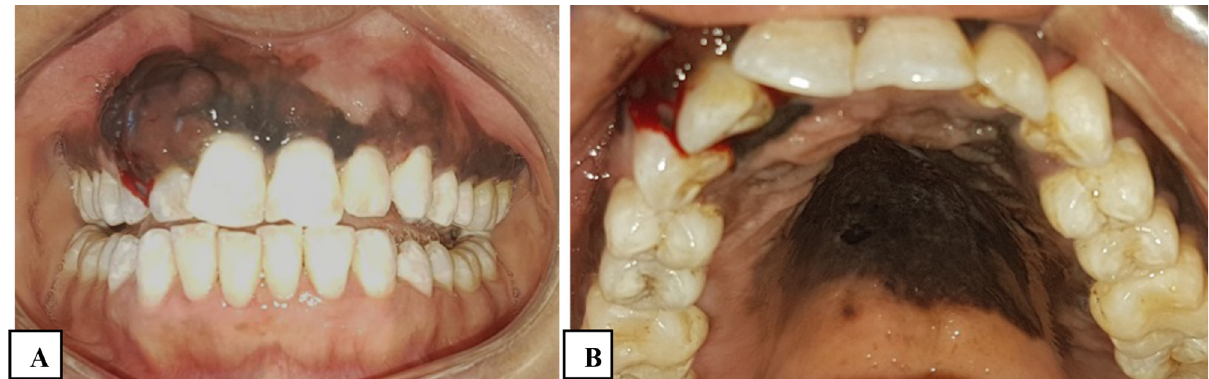
Fig. 1. Clinical presentation: A. An extensive pigmented lesion with variegation was seen in the maxillary buccal gingiva and alveolar mucosa from tooth #16 extending to #27 with ulcerated soft and friable nodule of 2cm long. B. Patchy dark pigmentations were also found in the whole palate.